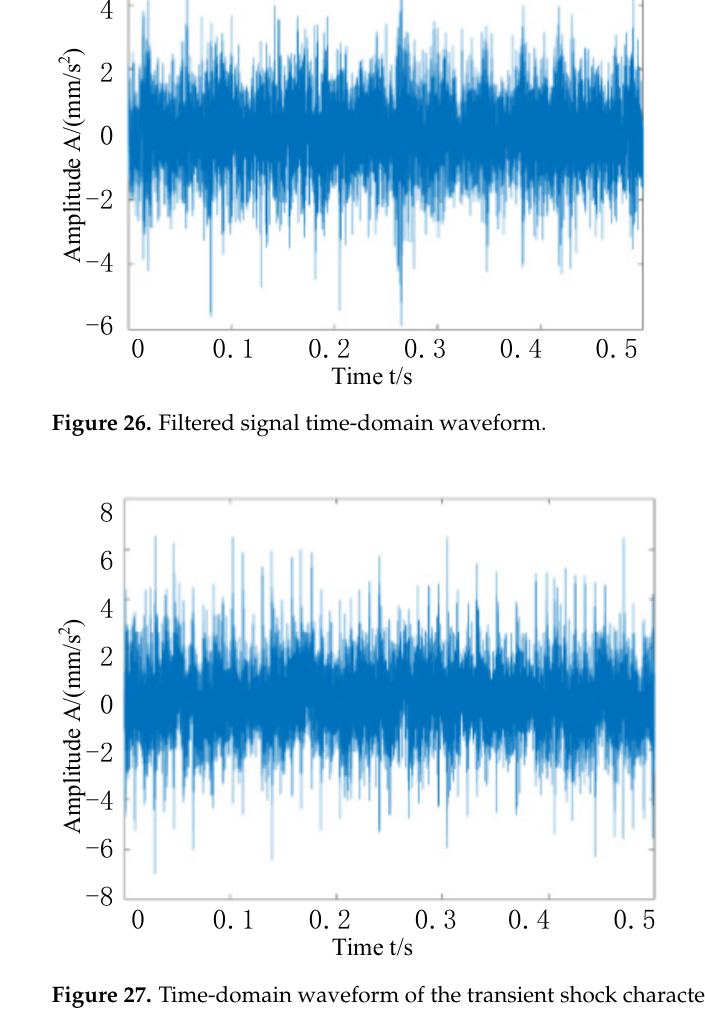
Figure 27. Time-domain waveform of the transient shock characteristics.